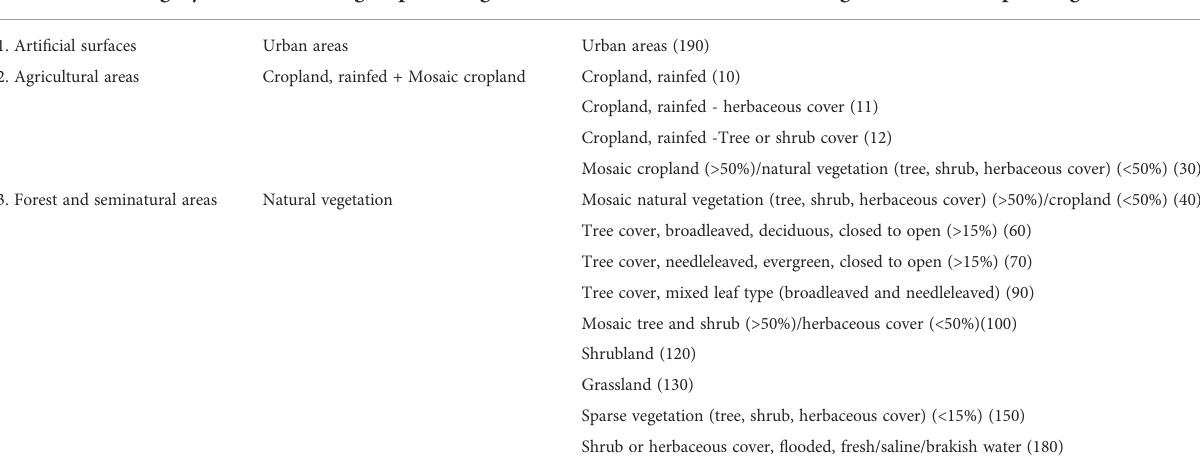
TABLE 1 Corine main categories and corresponding “ ESA CCI groups of categories ” employed in this study with the list of included ESA CCI categories. Corine main